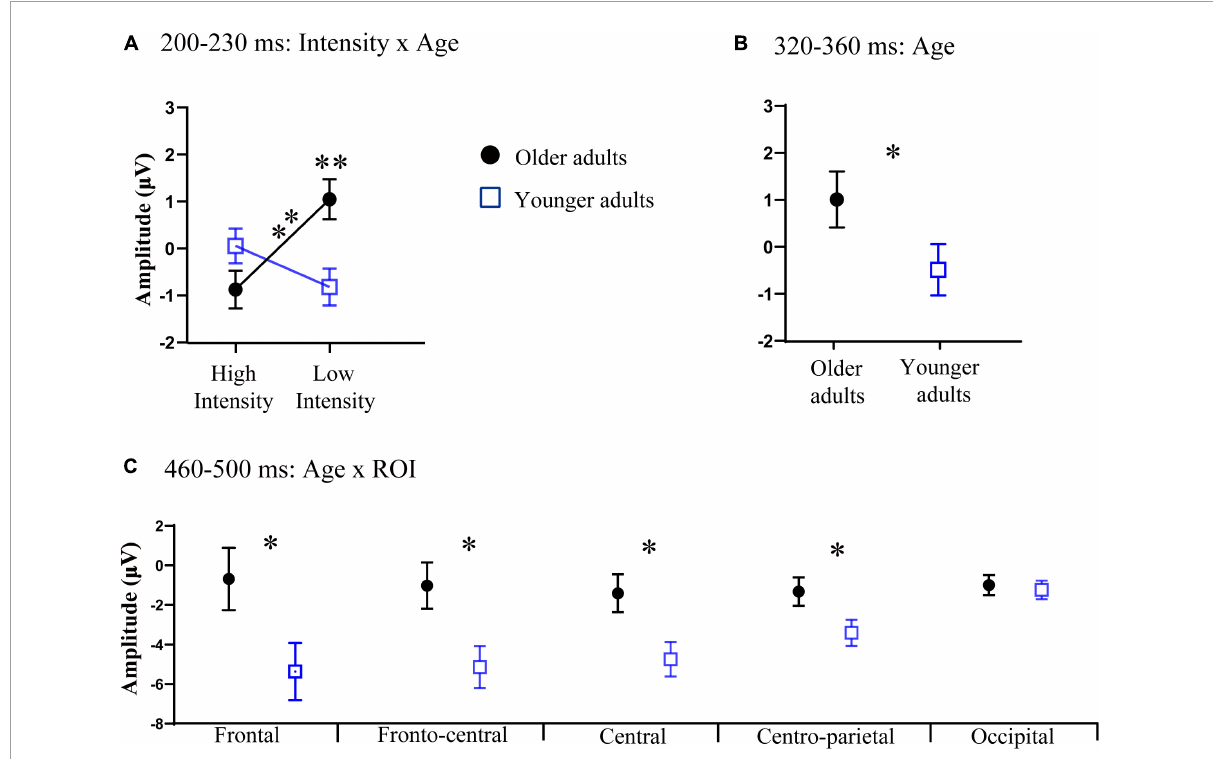
FIGURE4 (A) Significant interaction between intensity and age at 200–230 ms relative to auditory onset. (B) Significant main effect of age at 320–360 ms relative to auditory onset. (C) Significant interaction between age and the region of interest (ROI) at 460–500 ms relative to auditory onset. Error bars are the standard error of the mean (SEM); * p < 0.05, ** p <